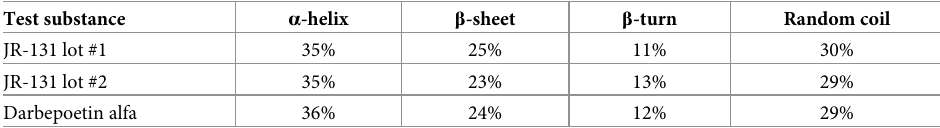
Table 1. Analysis of the secondary structure of JR-131 and darbepoetin alfa from CD